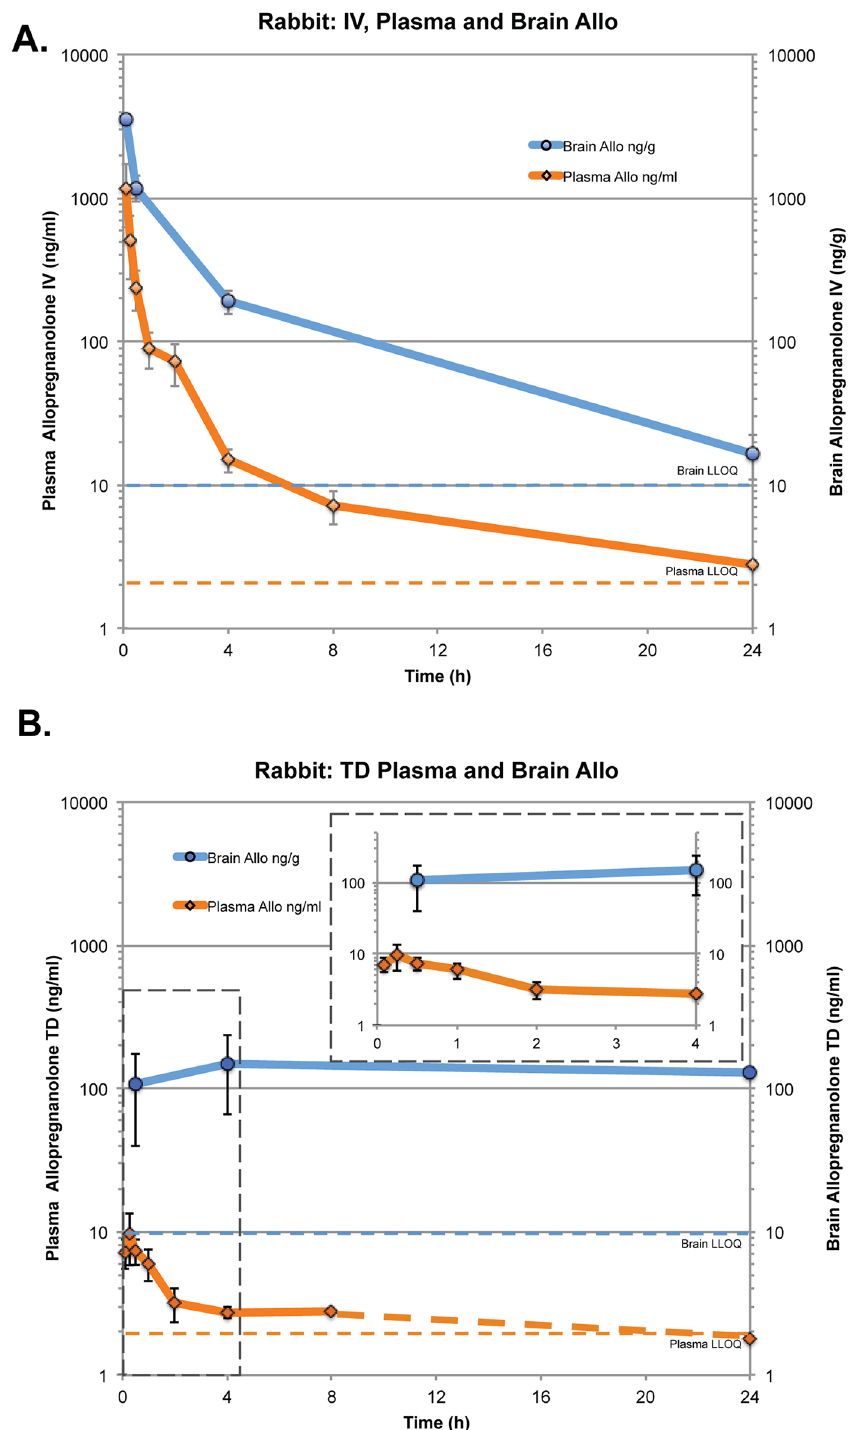
Fig 1. Rabbit plasma and brain concentration-time profiles of allopregnanolone following intravenous (IV) bolus or transdermal (TD) administration. A. Dosing at 3 mg/kg IV bolus using 1.5 mg/ml Allo solution in 20% HBCD in nine female New Zealand rabbits ( n = 1 – 9 per time point) and B. Dosing 5 mg/kg TD using 20 mg/ml Allo solution in DMSO administered to nine adult female New Zealand rabbits ( n = 1 – 9 per time point). Data points represented as mean ± SD. LLOQ: Lower Limit of